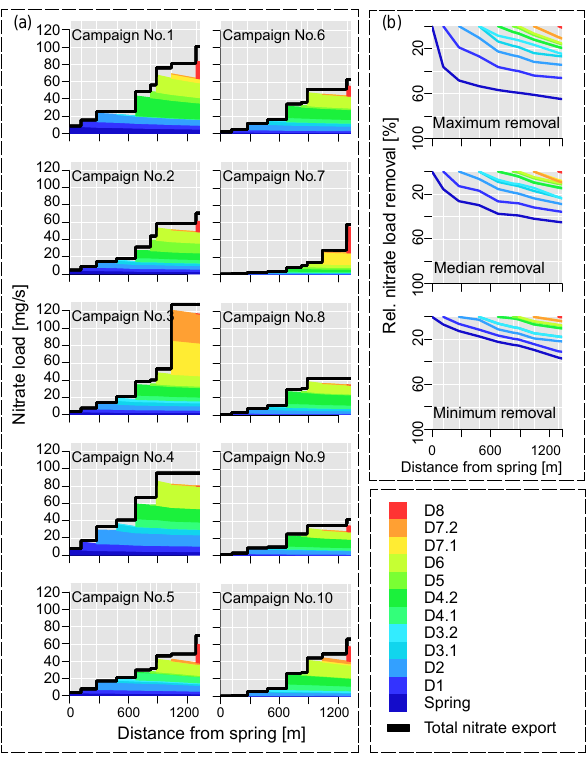
Figure 5. (a) In-stream nitrate loads per source for all days (the black line presents cumulative nitrate load emissions without in- stream removal). (b) Maximum, median and minimum in-stream nitrate load removal per source relative (%) to the total emitted ni- trate load.